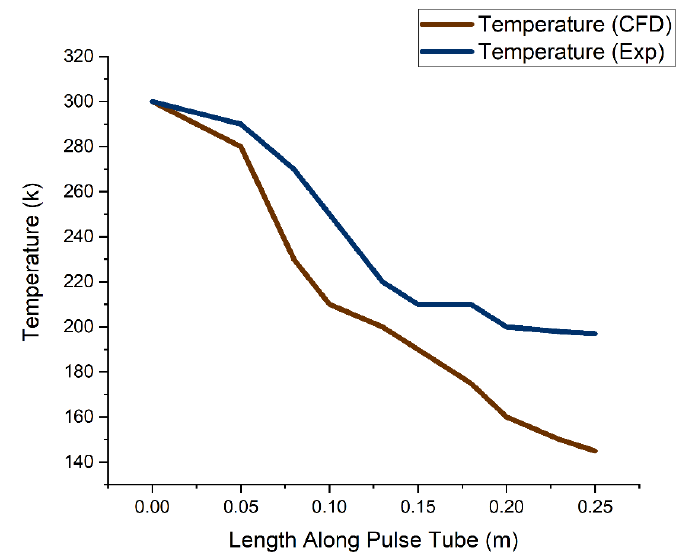
Figure 13. Comparison of variation of temperature along the pulse tube length.